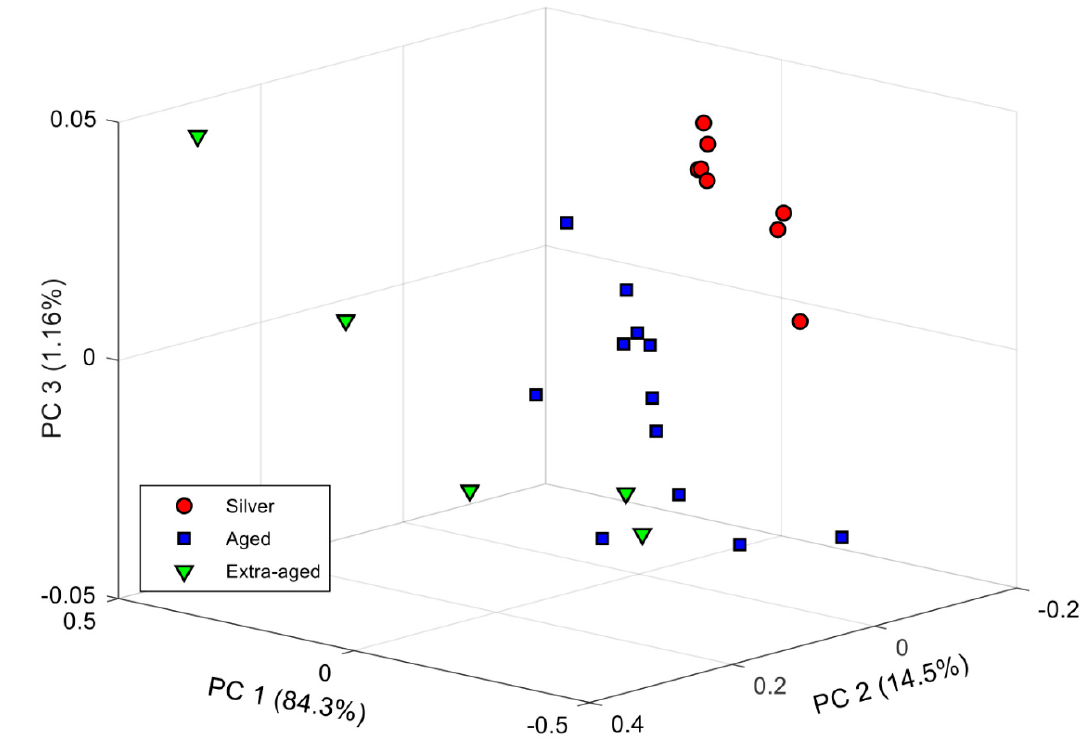
Figure 5. PCA score plot of the three first components obtained after analysis of tequila samples. As can be seen, some clustering is obtained according to different tequila classes.